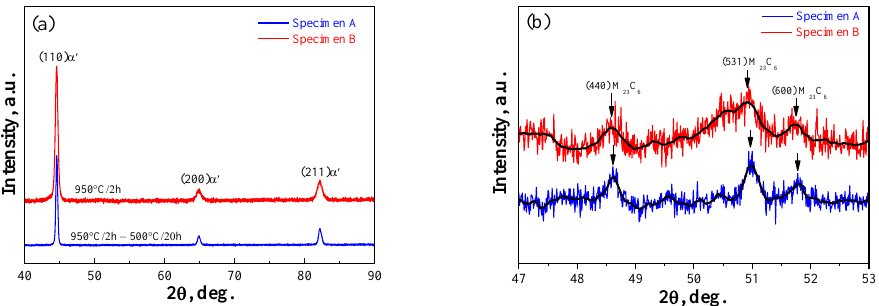
Figure 4. X-ray diffraction (XRD) patterns of the two steel specimens: ( a ) diffraction angles from 40° to 90° and ( b ) detailed information between diffraction angles from 47° to 53°. Online version in color.